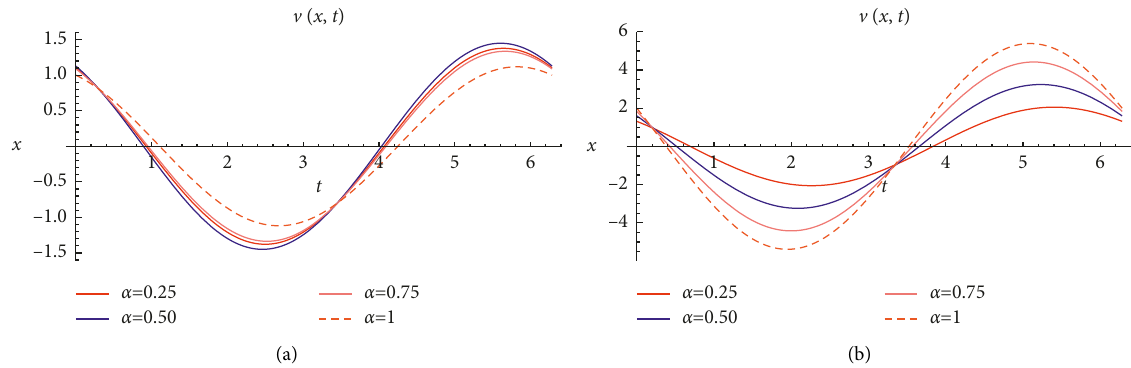
Figure 4: Plot of v ( x,t ) for real part and imaginary part for different values. (a) Real part of v ( x, t ) for equation (1) at t � 1. (b) Imaginary part o v ( x, t ) for equation (1) at t � 1. Table 1: The two-scale results for u ( x,t ) and v ( x,t ) with μ � η � 1 and t � 0 . 01 when α � 0 . 95. Sr. No.